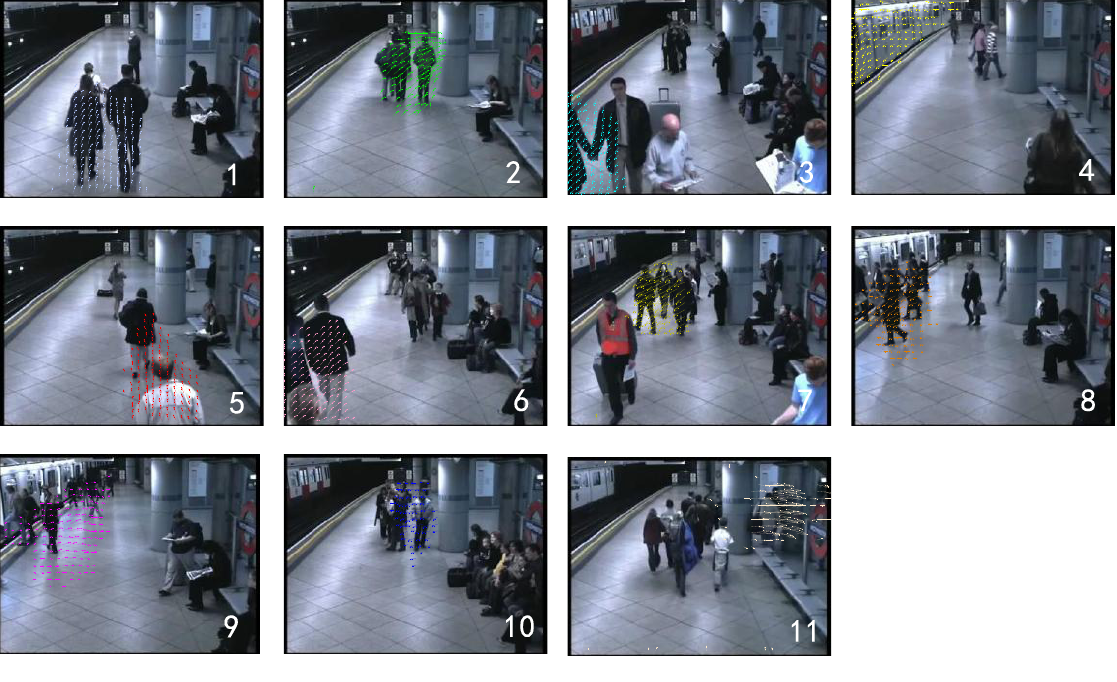
Figure 8. The experimental results on the subway dataset. ( a ) Top: illustration of the top 11 topics; ( b ) Bottom: the timelines of the 11